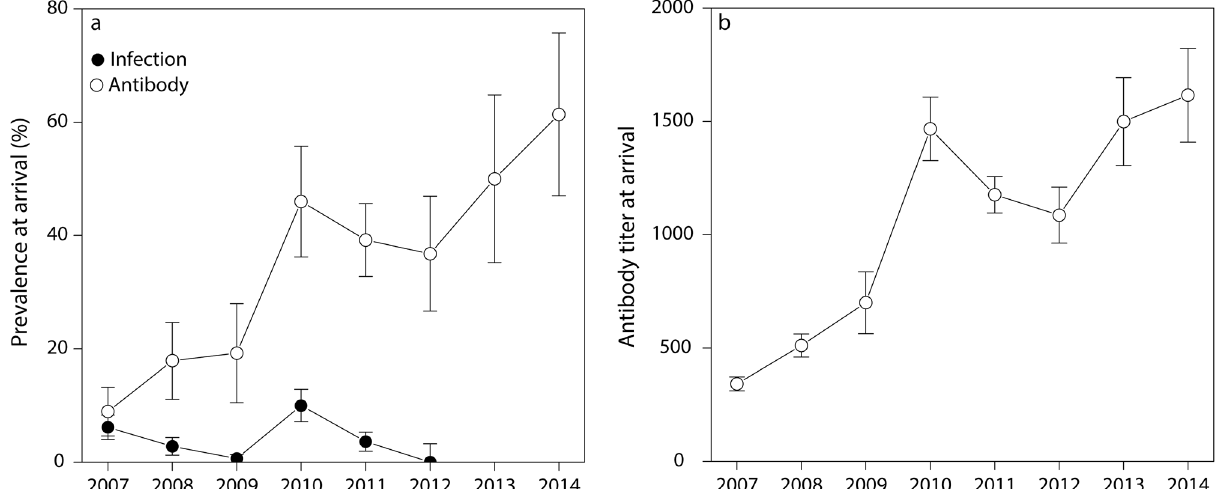
Figure 2. Infection status and serostatus of apparently healthy Northern common eiders upon arrival to Mitivik Island. Annual ( a ) prevalence (± 95% c.i.) of P. multocida infection and seroprevalence (± 95% c.i.), and ( b ) average antibody titer (± s.e.m.). N samples infection status: 472 (2007), 430 (2008), 475 (2009), 420 (2010), 469 (2011), 90 (2012). N samples serostatus: 168 (2007), 123 (2008), 78 (2009), 100 (2010), 222 (2011), 87 (2012), 44 (2013), 44 (2014). Note that serostatus of 2013 and 2014 are depicted in the graphs, however these were not included in the models assessing associations with the annual real-time reproductive number (R t